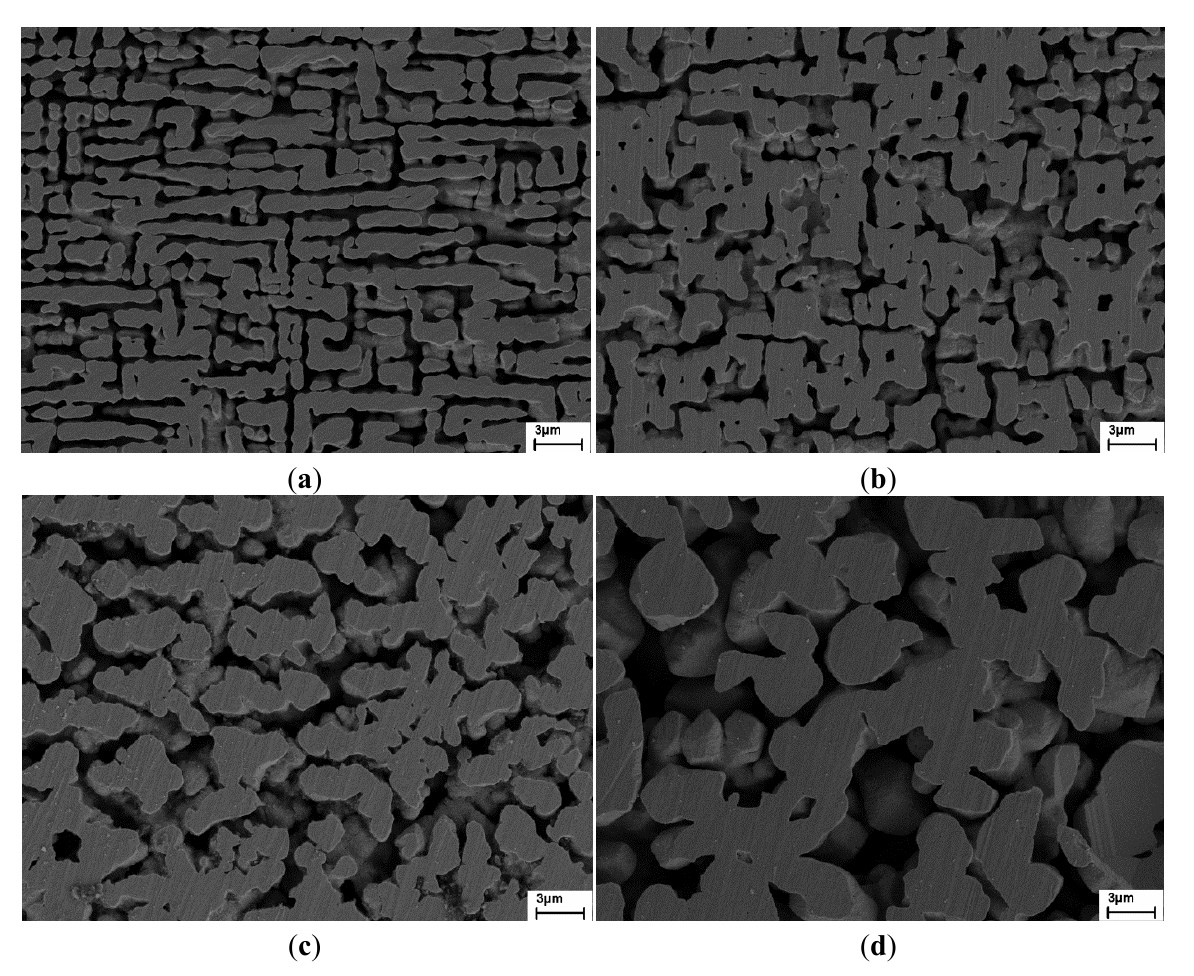
Figure 2. Microstructure of the superalloy membranes as a function of the cooling